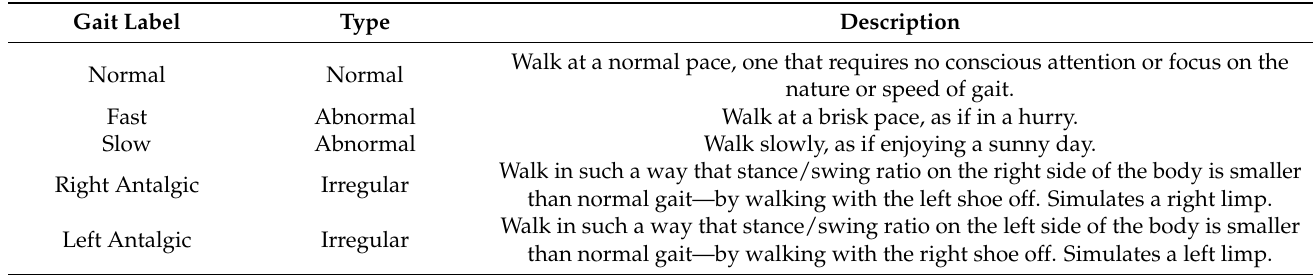
Table 4. Gait Types Used to Test the Prototype Gait Monitoring System.